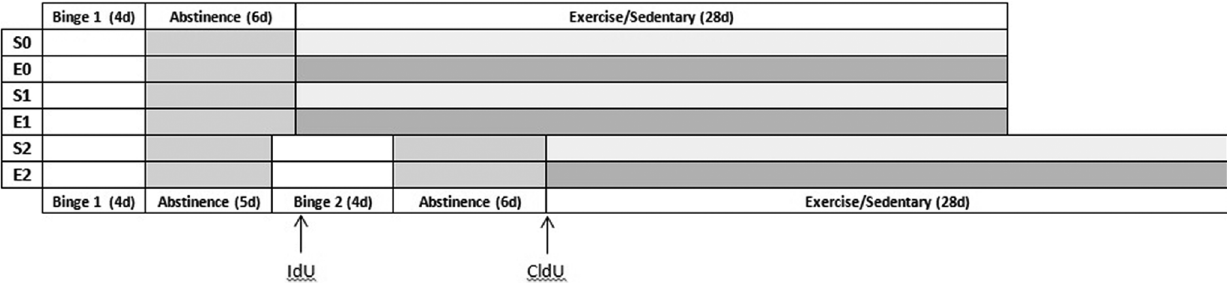
Figure 1. Experimental design and time course of events. Animals underwent either 0 (control diet), 1 or 2 binges. Beginning 7 days after the last binge, half the animals in each group exercised for 28 days (groups E0, E1, E2). In order to label cells generated in response to the first binge, all animals received IdU 7 days after the last dose of ethanol. In order to label cells generated in response to the second binge, animals in the Two Binge groups (S2 and E2) received CldU 7 days after the end of the second binge. All animals were sacrificed 35 days after the last